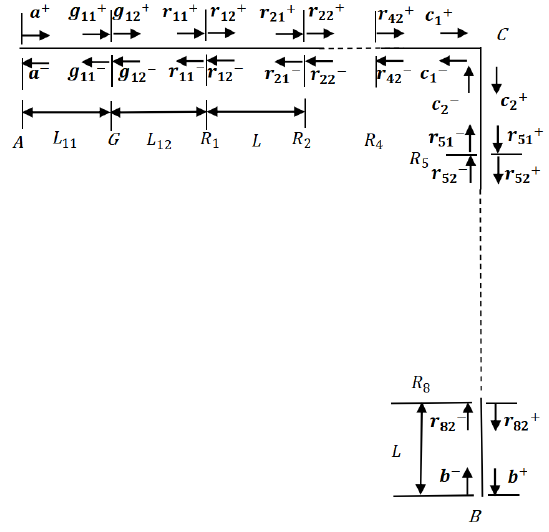
Figure 10. Vibration wave components in the LR beam.